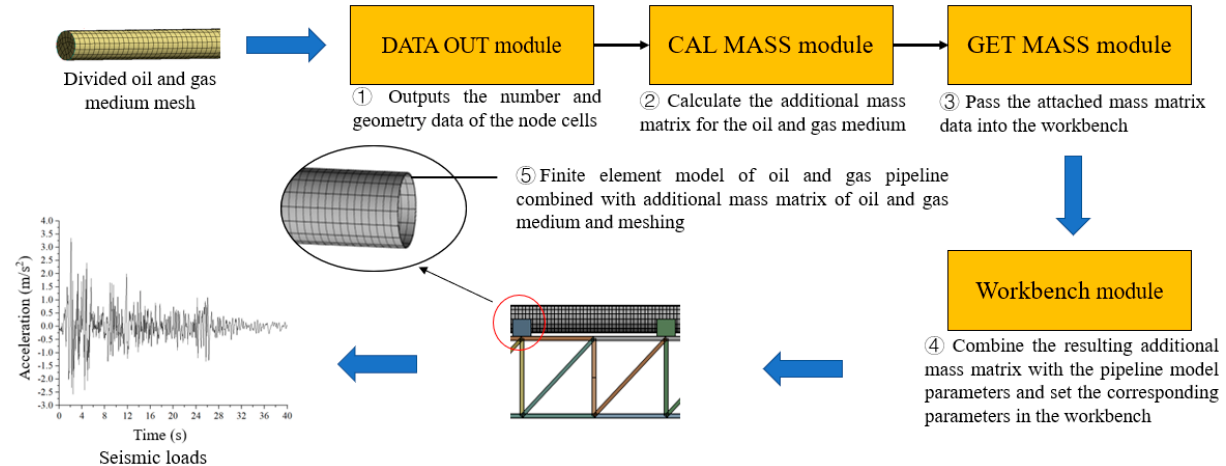
Figure 3. Finite element model and establishment method of an oil and gas transmission pipeline by the additional-mass method.